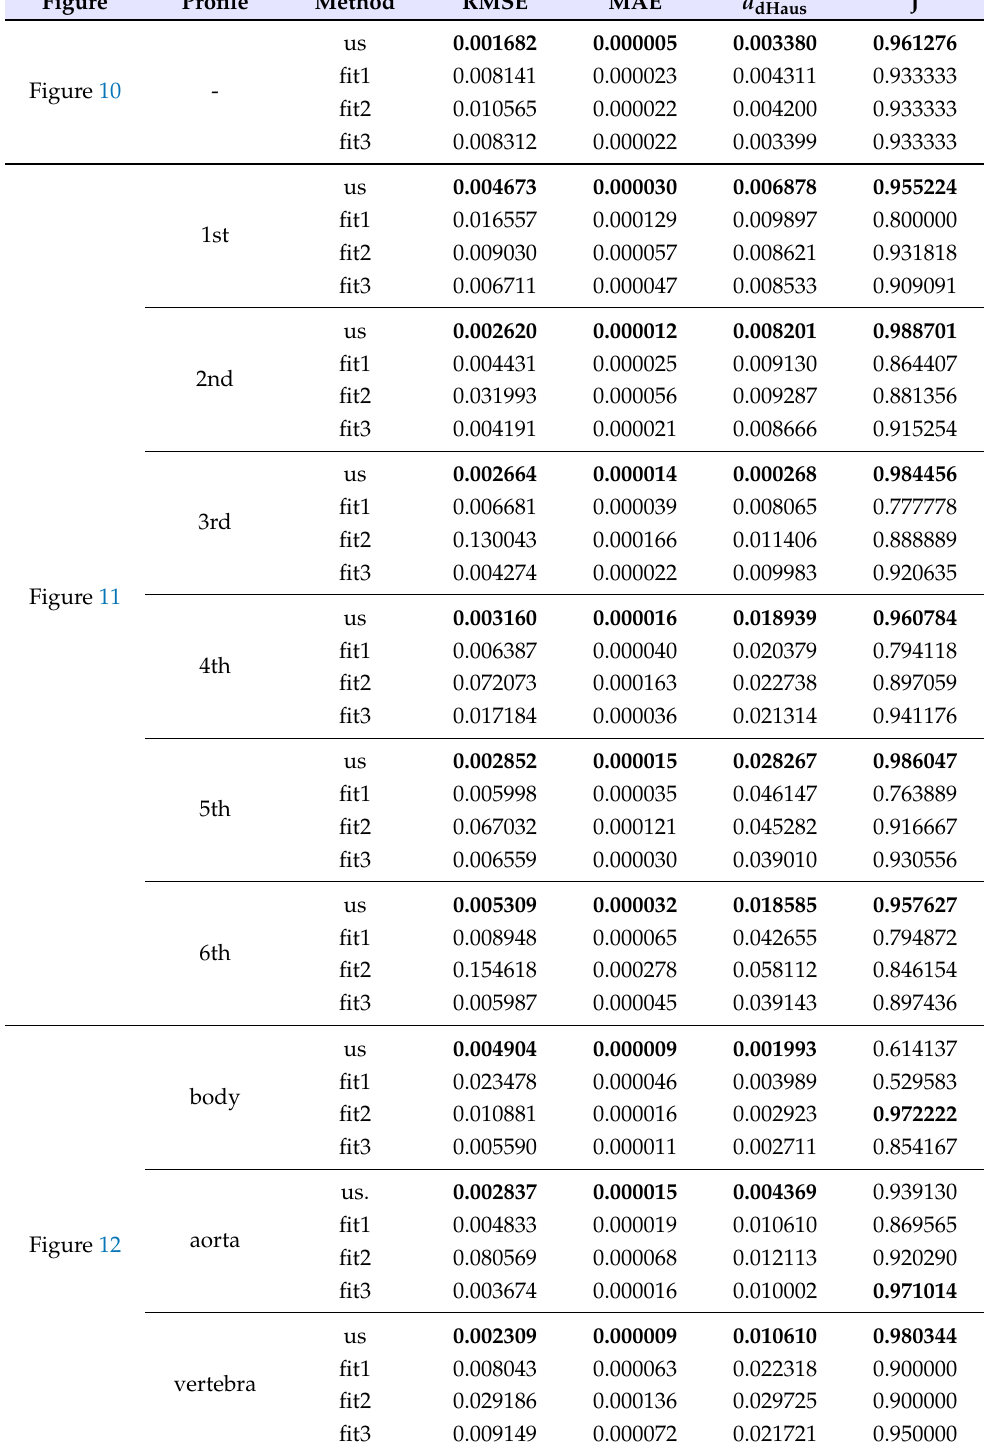
Table 3. Indicators for the examples in Figures 10–12. For each profile we report: the Root Mean Squared Error (RMSE), the Mean Absolute Error (MAE), the normalized directed Hausdorff distance d dHaus and the Jaccard index J . Here, fit1, fit2 and fit3 stand, respectively, for quadratic polynomial, piecewise cubic and smoothing spline fitting. For each figure and each indicator, the best performance is reported in